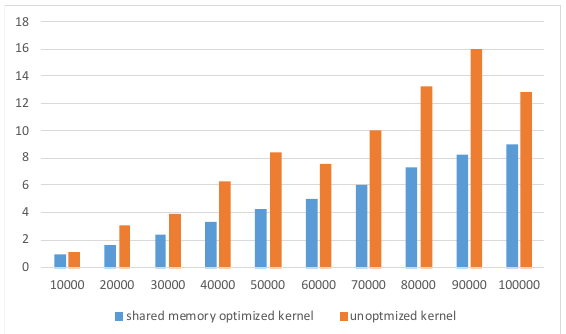
Fig. 12. The comparison of time cost between shared memory optimized kernel and unoptimized kernel of GPU programs on different size of dataset. In the figure, the X axis represents the size of dataset (number of records) and the Y axis represents the time cost of GPU kernels (units in millisecond). The blue bar graph is the time cost of GPU kernels optimized with shared memory and the orange bar graph is the time cost of unoptimized GPU kernels.